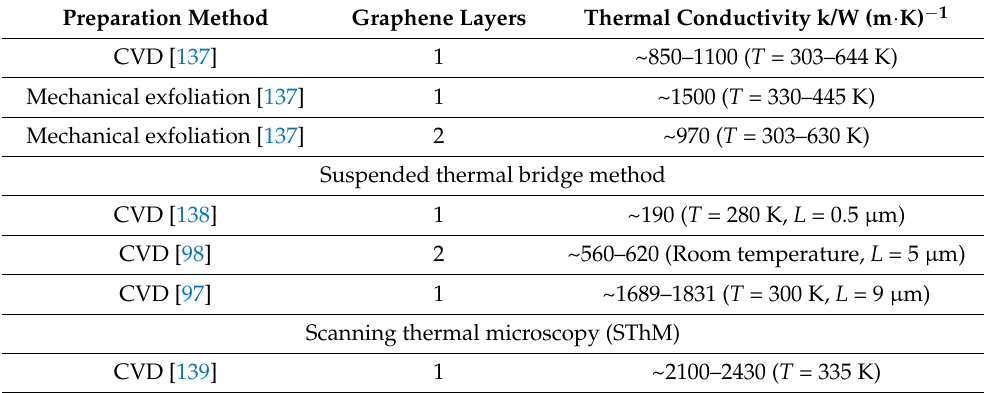
Table 1. Cont. Preparation